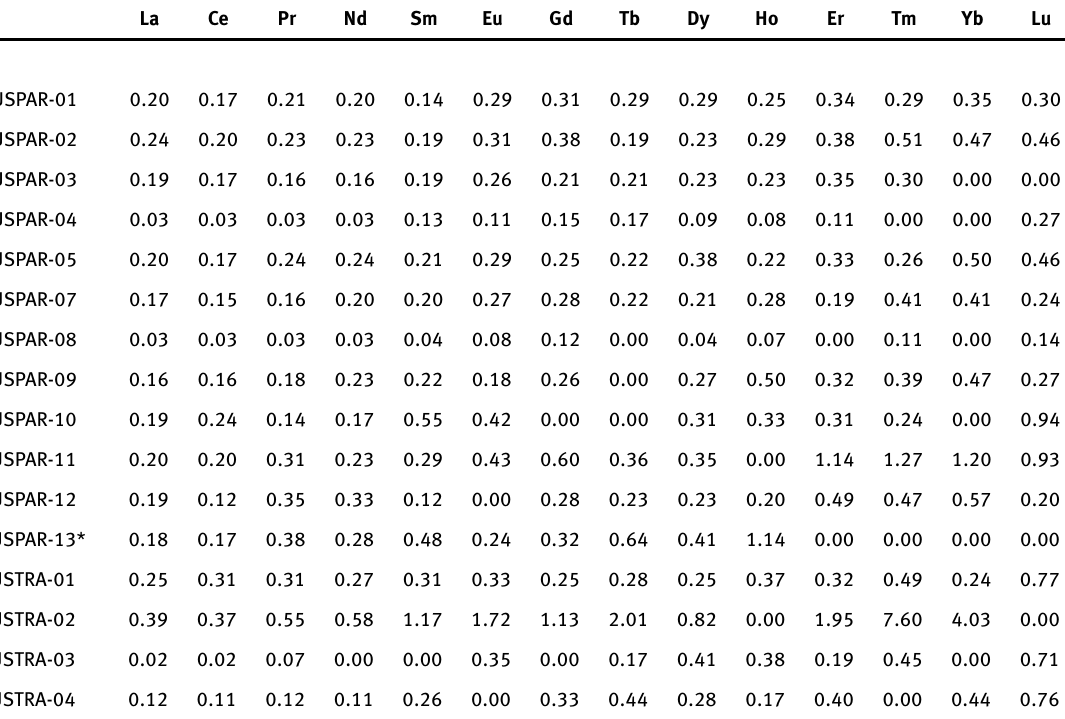
Table 5c: Trace element concentrations in ppm determined by LA-ICP-MS normalized to Continental Crust (Continental Crust data taken from Wedepohl, 1995). Each concentration is the average value of three measurements; * the average value of two